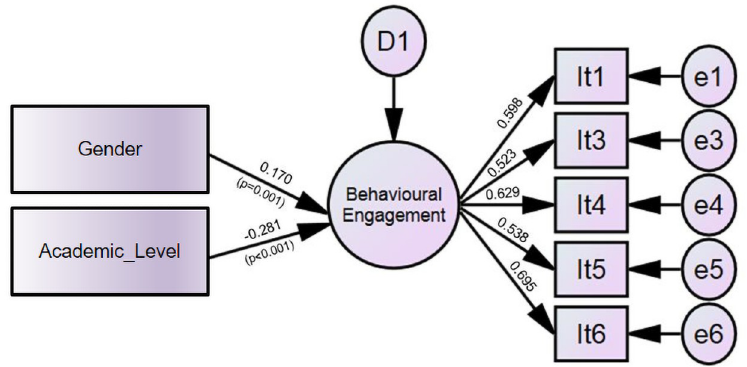
Fig 1. Structural model of variables with a significant contribution (p < 0.05) to university engagement in the Brazilian sample.